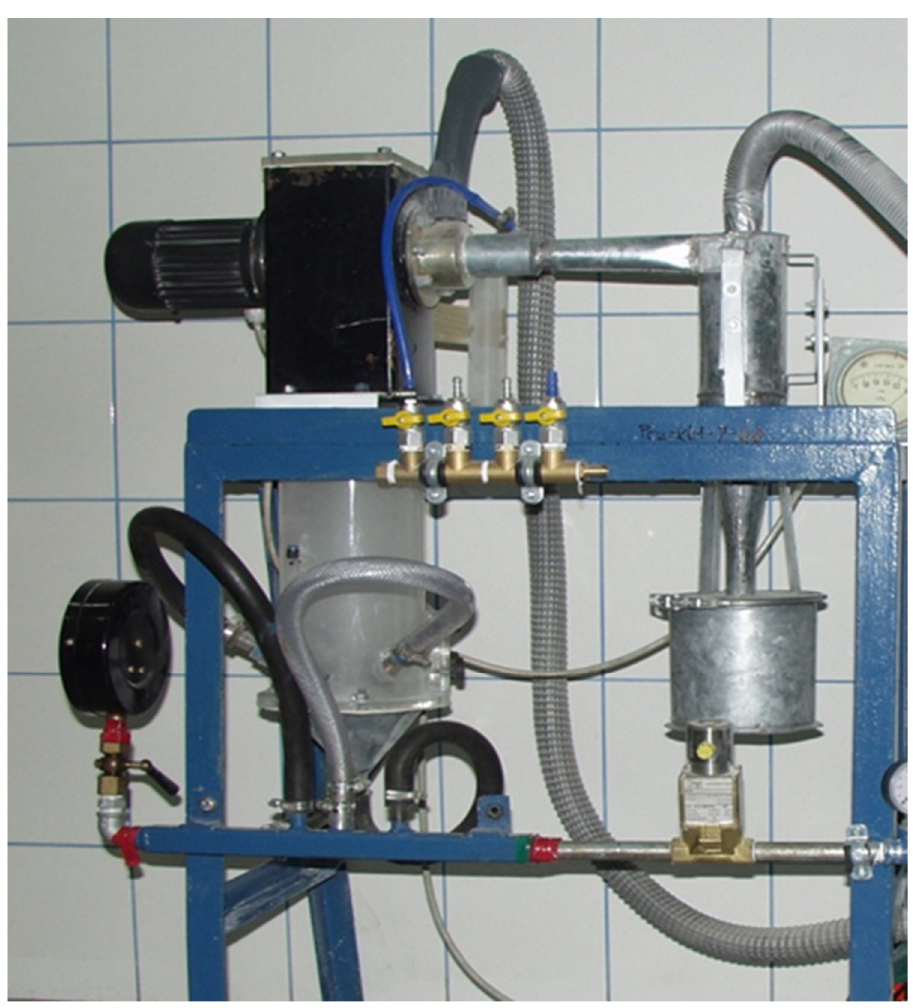
Figure 1. Experimental stand.